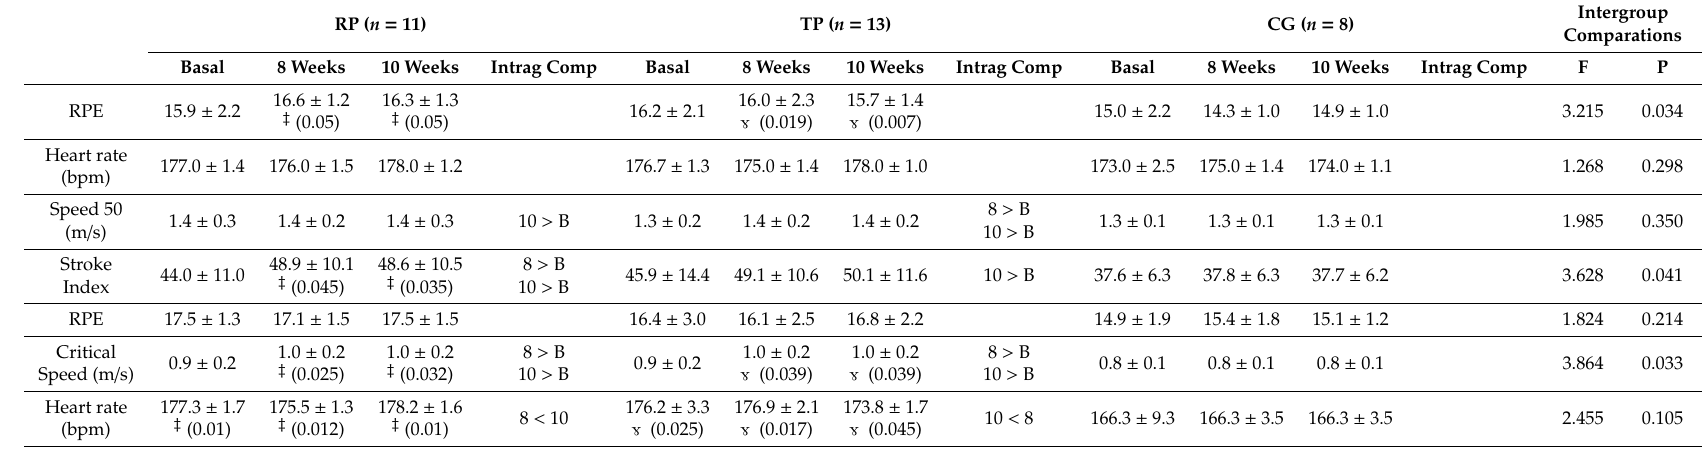
Table 4. Swimming performance results before, after 8 weeks of training plus two weeks of tapering in the three groups, mean ± SD.